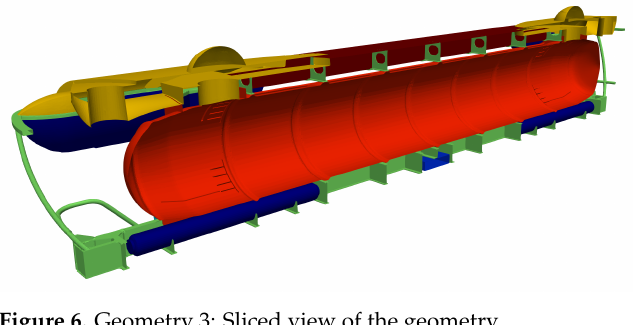
Figure 6. Geometry 3: Sliced view of the geometry.